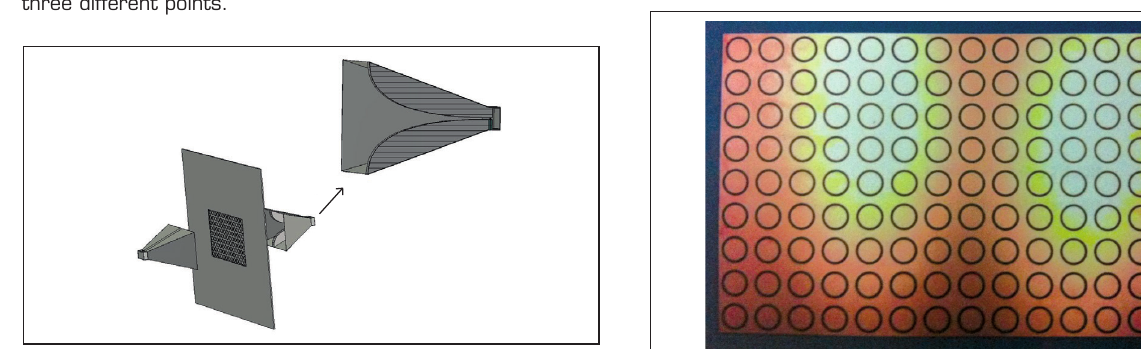
Figure 7. Constructed FSS array.